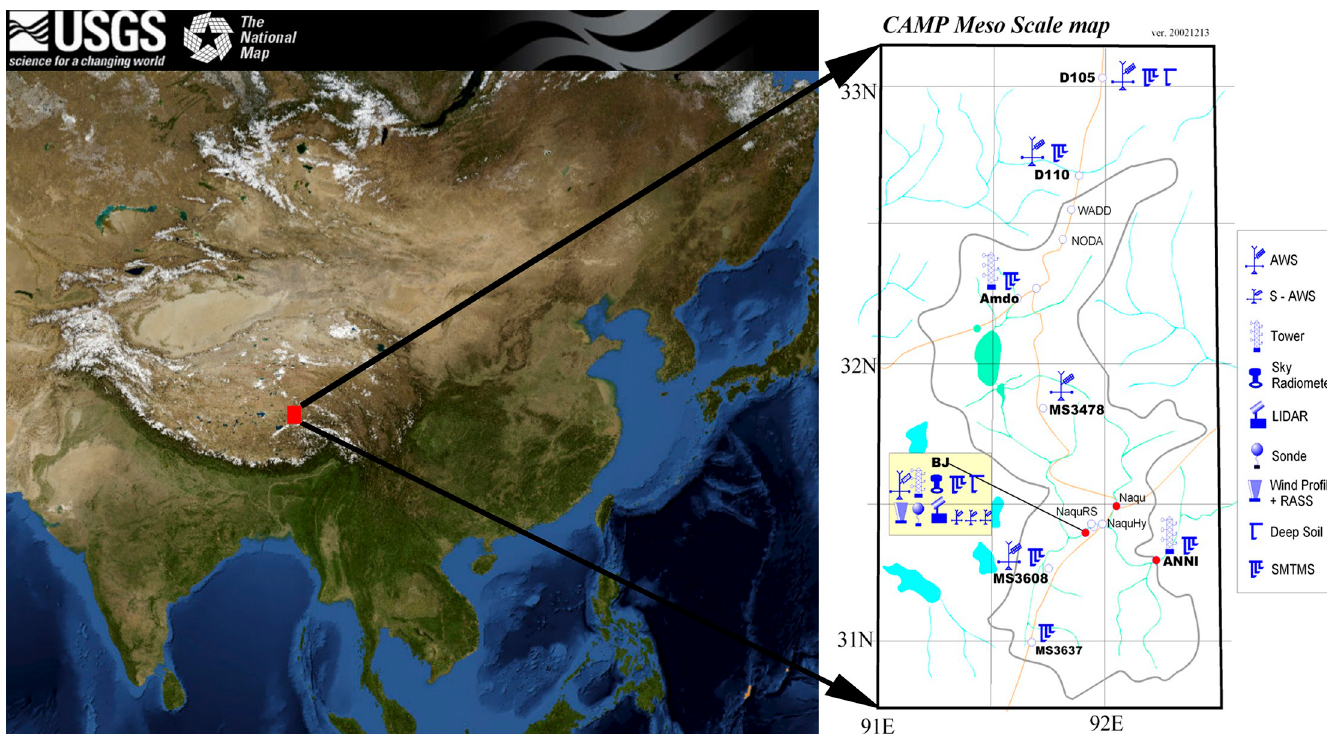
Fig 1. In-situ observation sites within the CAMP/Tibet region. The map was plotted by USGS website. Detailed information concerning the sampling sites is shown in http://viewer.nationalmap.gov/viewer/.